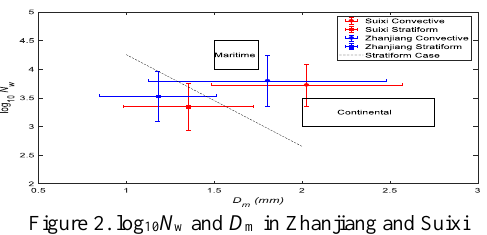
Figure 2. log 10 N w and D m in Zhanjiang and Suixi The Gamma distribution function is 𝑁(D) = 𝑁 0 𝐷 𝜇 𝑒 −𝛬𝐷 . The